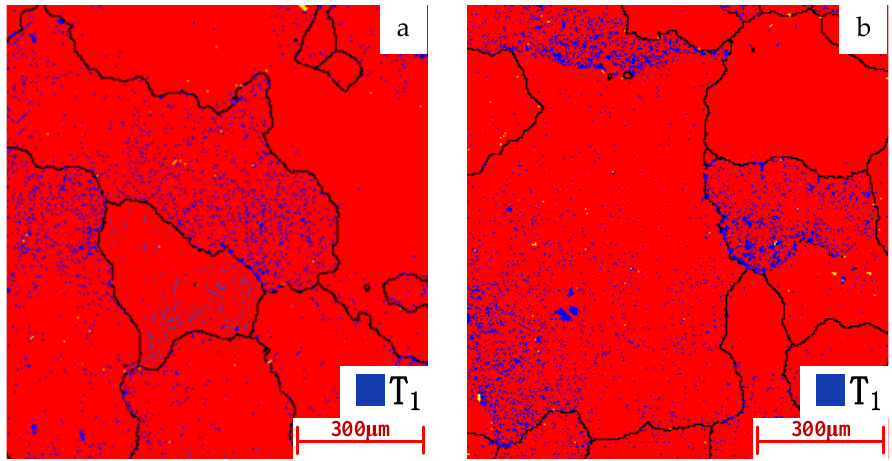
Figure 7. EBSD phase mapping showing the distribution of the secondary network at the top of the ingot formed ( a ) with USMT and ( b ) without USMT. Table 3. Reduction rate (η) of the area fraction (AF) of the coarsening precipitate phase. Top Half Axis Bottom AS with USMT(μm)